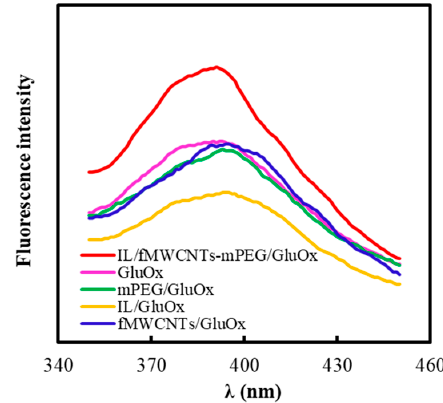
Figure 9. Fluorescence spectra of GluOx, mPEG/GluOx, IL/GluOx, fMWCNTs/GluOx, and IL/fMWCNTs-mPEG/GluOx in PBS (50 mM, pH 7.0, 25 °C). The final amounts of GluOx, mPEG, IL, and fMWCNTs were 3.3 × 10 − 6 mM, 2.67 × 10 − 1 mg/mL, 0.67% in volume, and 3.3 × 10 − 3 mg/mL, respectively.